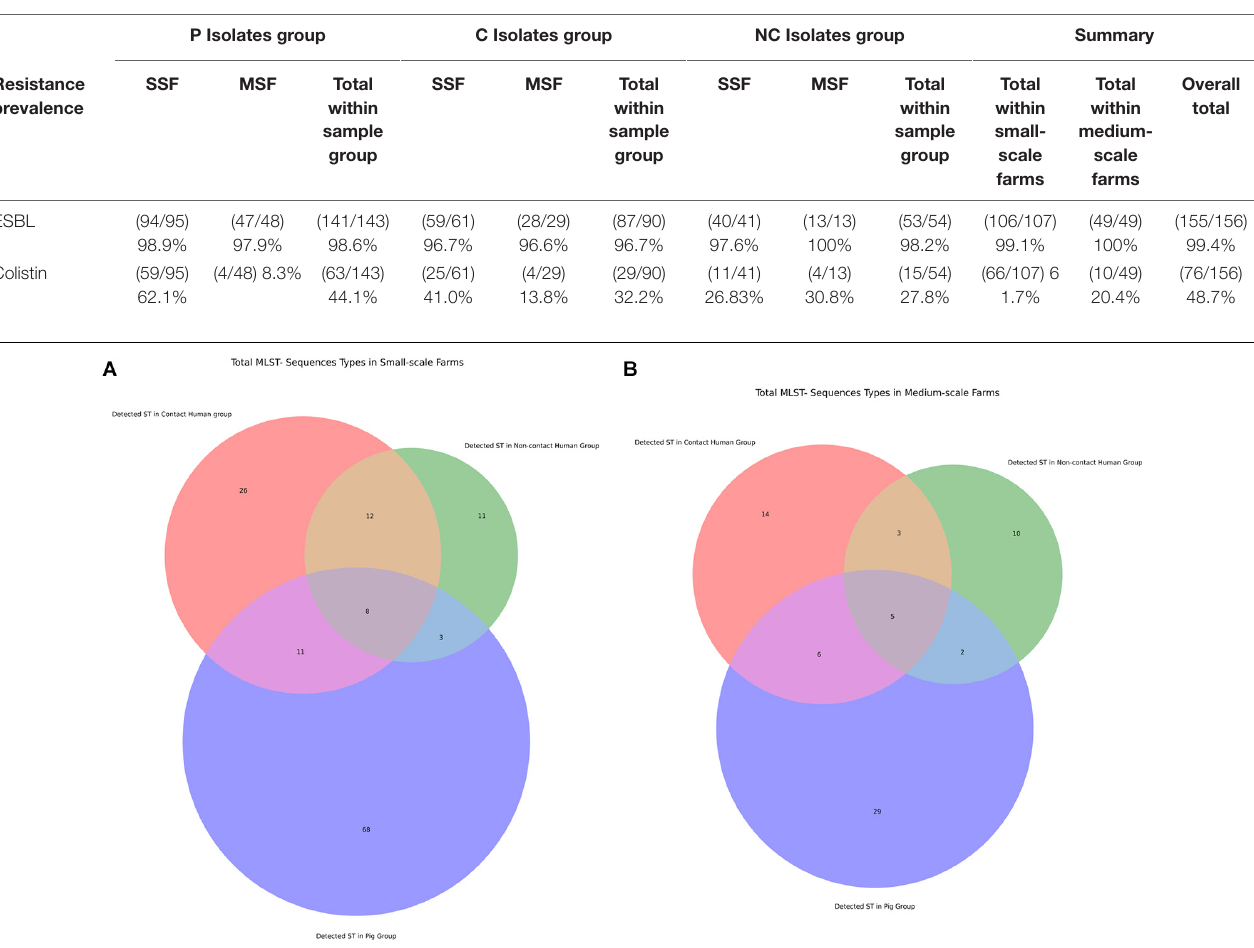
TABLE 2 | Farm prevalence of ESBL and colistin resistance genes.